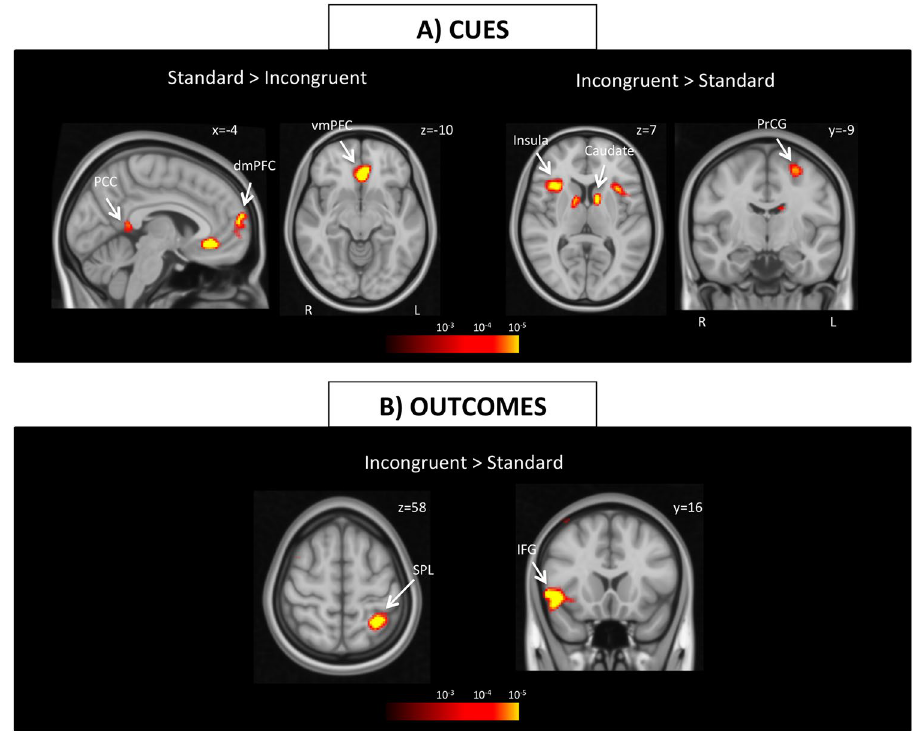
Figure 3. Brain activation during cue and outcome presentation. ( A ) Brain regions that were more active during standard and incongruent cues are depicted. PCC and medial prefrontal areas demonstrated greater activation during standard cues, whereas bilateral insula, dorsal caudate and left precentral gyrus showed enhanced activation during incongruent cues. ( B ) No region reached significance for Standard > Incongruent outcomes, however, left SPL and right inferior frontal gyrus demonstrated stronger activation during incongruent outcomes. All clusters displayed on the maps survive correction for multiple comparisons using a cluster-defining threshold of p < 0.001 and 10,000 Monte Carlo simulations at clusterwise p <